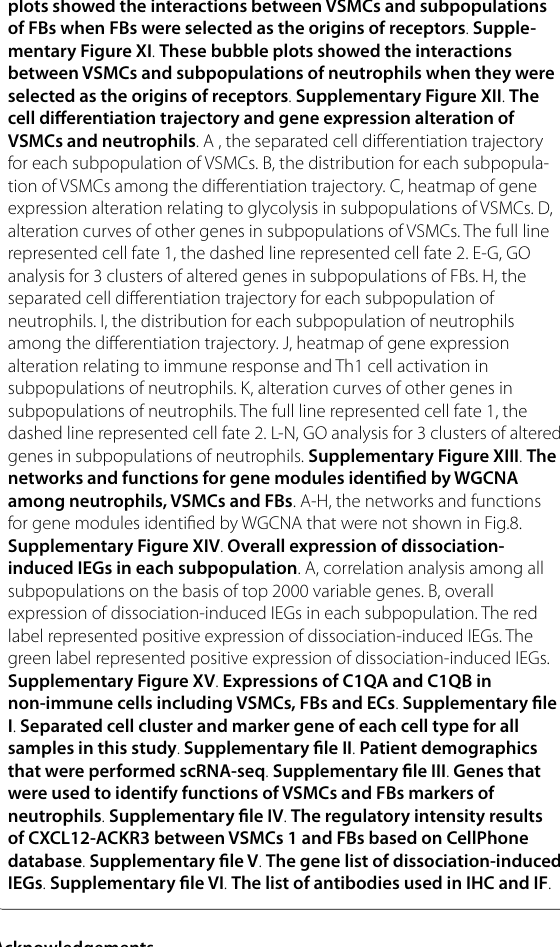
the dominance of each subpopulation in control and ATAD group. C, heatmap of marker genes for each subpopulation of T cells. D, t‑SNE and violin plots showed the expressions of representative marker genes for each subpopulation of T cells. E, the separated differentiation trajectory of FBs. F, the distribution of each subpopulation for FBs among the differentiation trajectory. G, alteration curves of other genes that was not shown in Fig.7. The full line represented cell fate 1, the dashed line represented cell fate 2. H‑I, heatmap and curves of gene expression alteration relating to mRNA and translational processes. The full line represented cell fate 1, the dashed line represented cell fate 2. J‑K, heatmap and curves of gene expression alteration relating to cell death and protein modification. The full line represented cell fate 1, the dashed line represented cell fate 2. Supplementary Figure X . These bubble